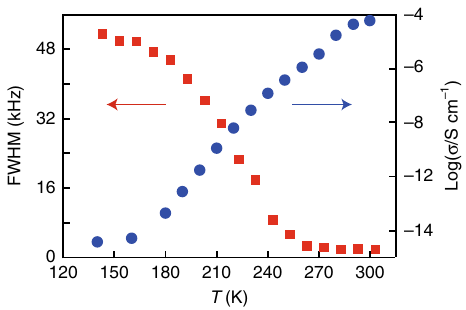
Fig. 5 Temperature dependence of 1 H NMR spectra and proton conductivity. Red squares and blue circles indicate FWHM of 1 H NMR spectra (Supplementary Fig. 37) and proton conductivity (pelletised sample, Supplementary Fig.